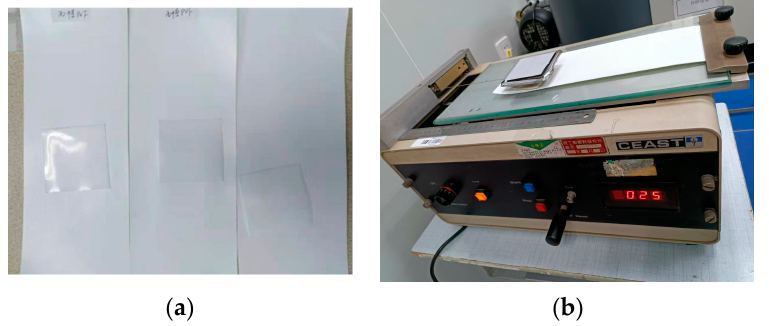
Figure 1. Coefficient of friction test between cable and membrane materials: ( a ) Membrane materials; ( b ) Test